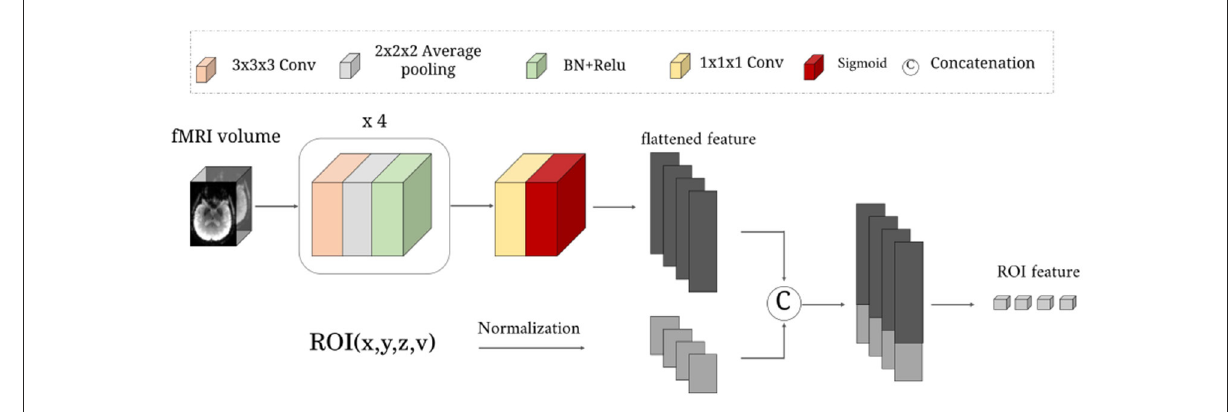
FIGURE2 The detailed structure of the RFLNet. The input is an example of three-dimensional fMRI volume with the size 64 × 64 × 48, and the ROI information of the anatomical atlas with the size N × 4. The FRFNet outputs the initial feature for each ROI.